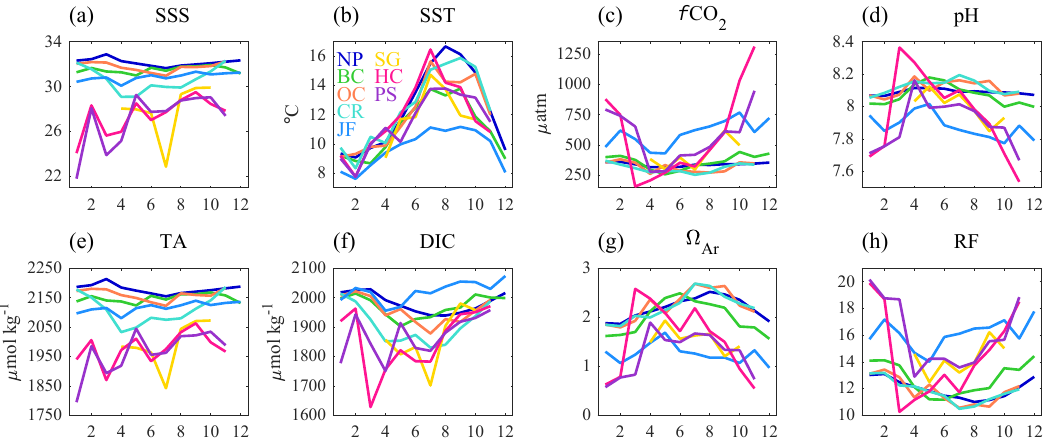
Figure 4. Near-surface (<10m) seasonal cycles of (a) SSS, (b) SST, (c) f CO 2 , (d) pH T , (e) TA, (f) DIC, (g) (cid:127) Ar , and (h) Revelle factor (RF) for the eight regions shown in Fig. 2c: North Pacific (NP), British Columbia (BC), Outer Coast (OC), Columbia River (CR), Juan de Fuca (JF), Strait of Georgia (SG), Hood Canal (HC), and Puget Sound